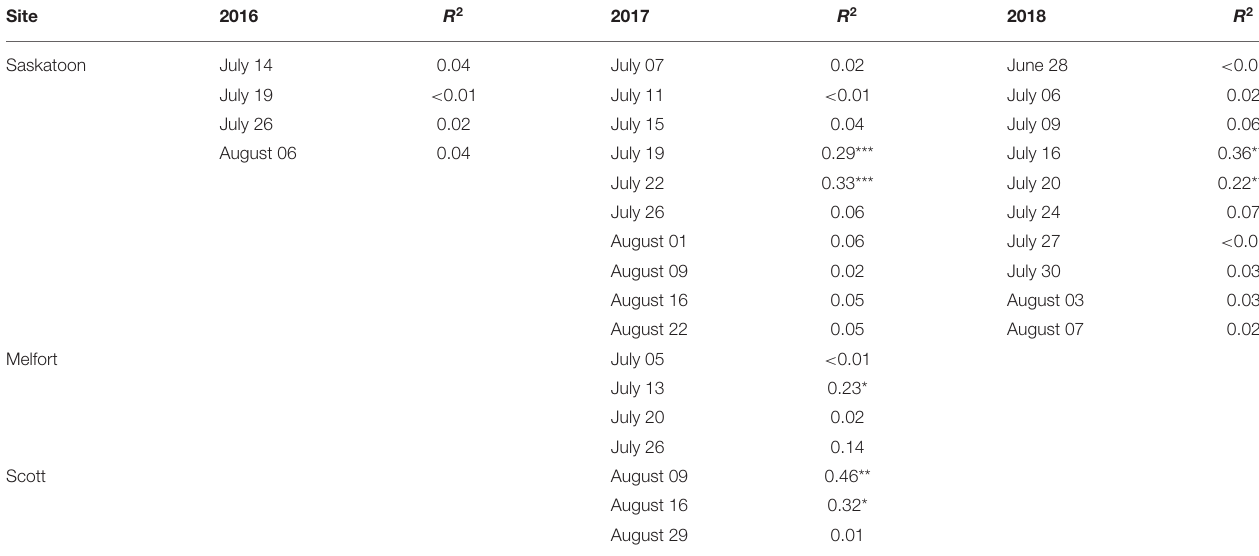
TABLE 3 | The coefficient of determination ( R 2 ) between flowering pixel numbers from a single image date and yield at Saskatoon, SK, Canada from 2016 to 2018 and at Melfort and Scott, SK, Canada in 2017.